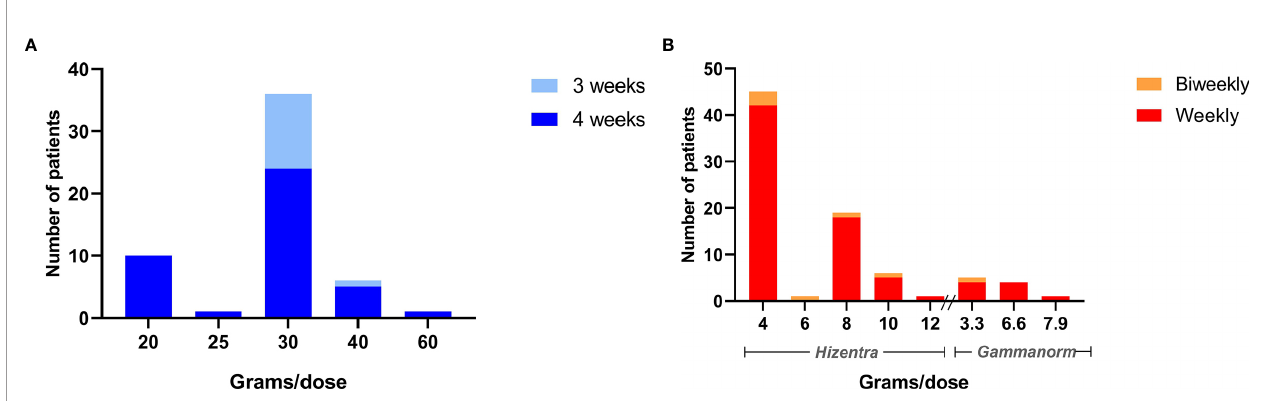
FIGURE 3 | The dosage in grams of Immunoglobulin for fSCIg and conventional SCIg therapy per patient. (A) The number of patients on the different fSCIg dose, in grams, after the end of the training sessions with corresponding intervals in therapy. (B) The number of patients on each dose of conventional SCIg, Hizentra (200 mg/ml) and Gammanorm (165mg/ml), after the end of training sessions with corresponding intervals